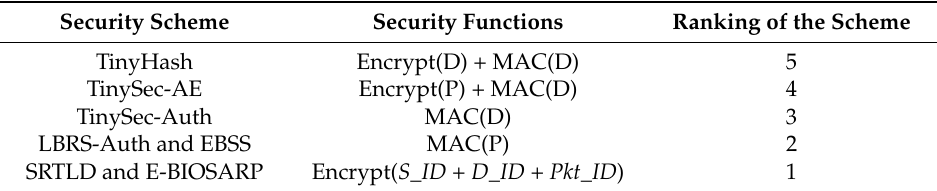
Table 2. Comparison of security